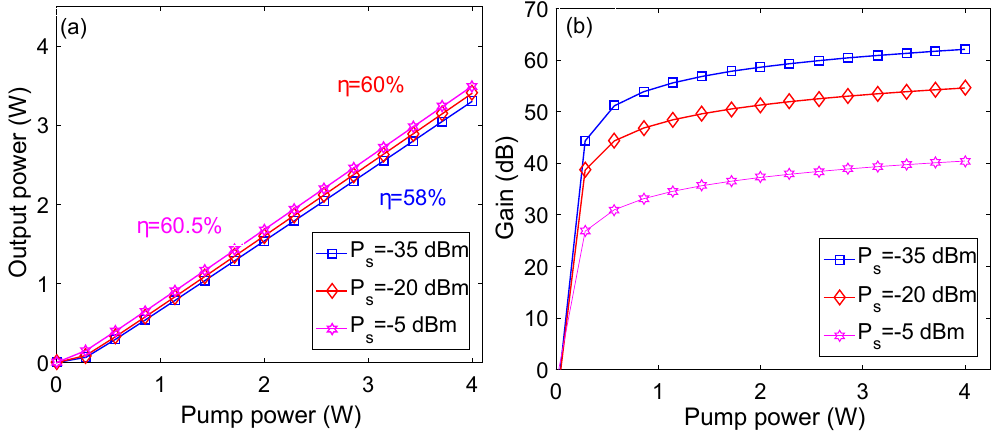
Figure 7. Pump power versus: ( a ) output power plots; ( b ) gain plots.